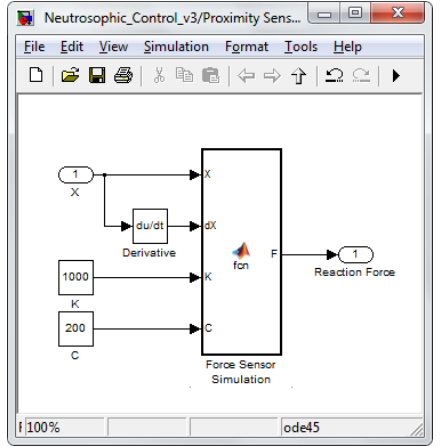
Figure 15. Force sensor simulation.